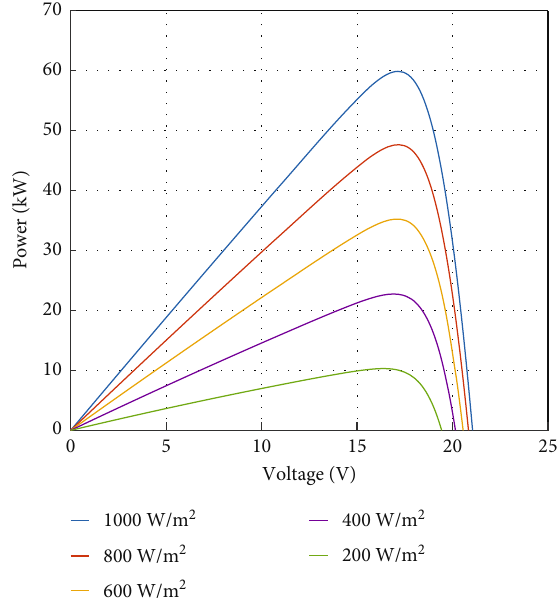
Figure 10: Irradiance e ff ect on power. Table 2: Economic characteristics of the SPV system in Ghana.